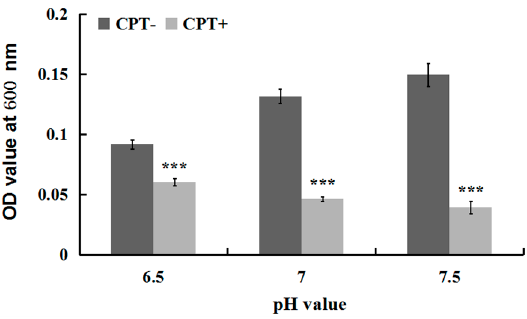
Figure 3. Effect of the pH value on the antibacterial activity of CPT against Acidovorax avenae subsp. avenae strain RS-2. The concentration of CPT is 0.50 mg/mL, and the incubation time is 8 h. ***: p < 0.001. Error bars represent the standard error of the mean ( n = 6). Data are from a representative experiment repeated twice with similar results.